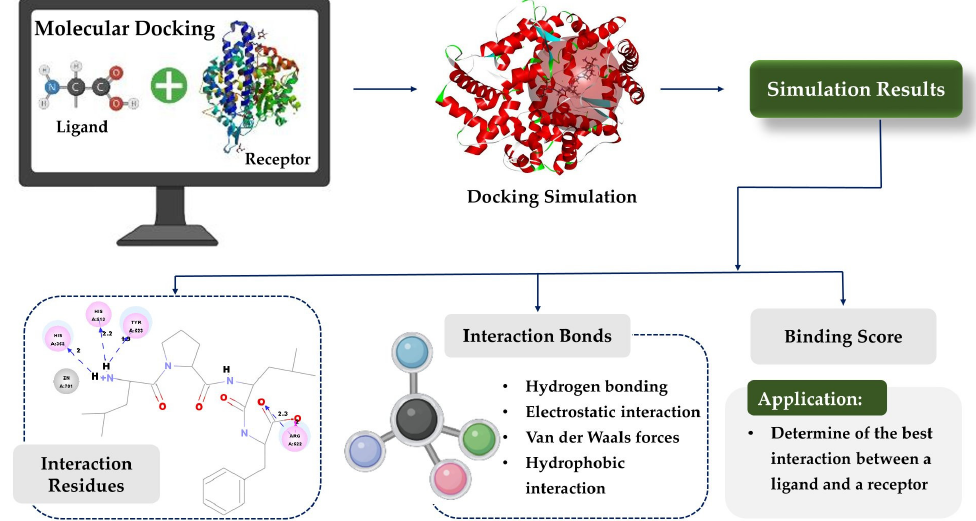
Figure 3. Flowchart for molecular docking (i) preparation receptor and ligands; (ii) docking; (iii) simulation results, including determining interaction residues, interaction bonds, and calculation binding mode score of a ligand to a receptor.